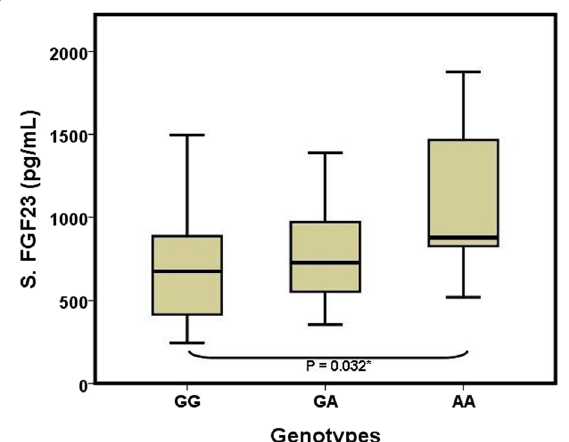
Fig. 3 Comparison of different genotypes of FGF23 gene rs7955866 SNP in CKD patients according to hypertension grade, showing the P value for the difference between GG and AA phenotypes in post hoc pairwise comparison